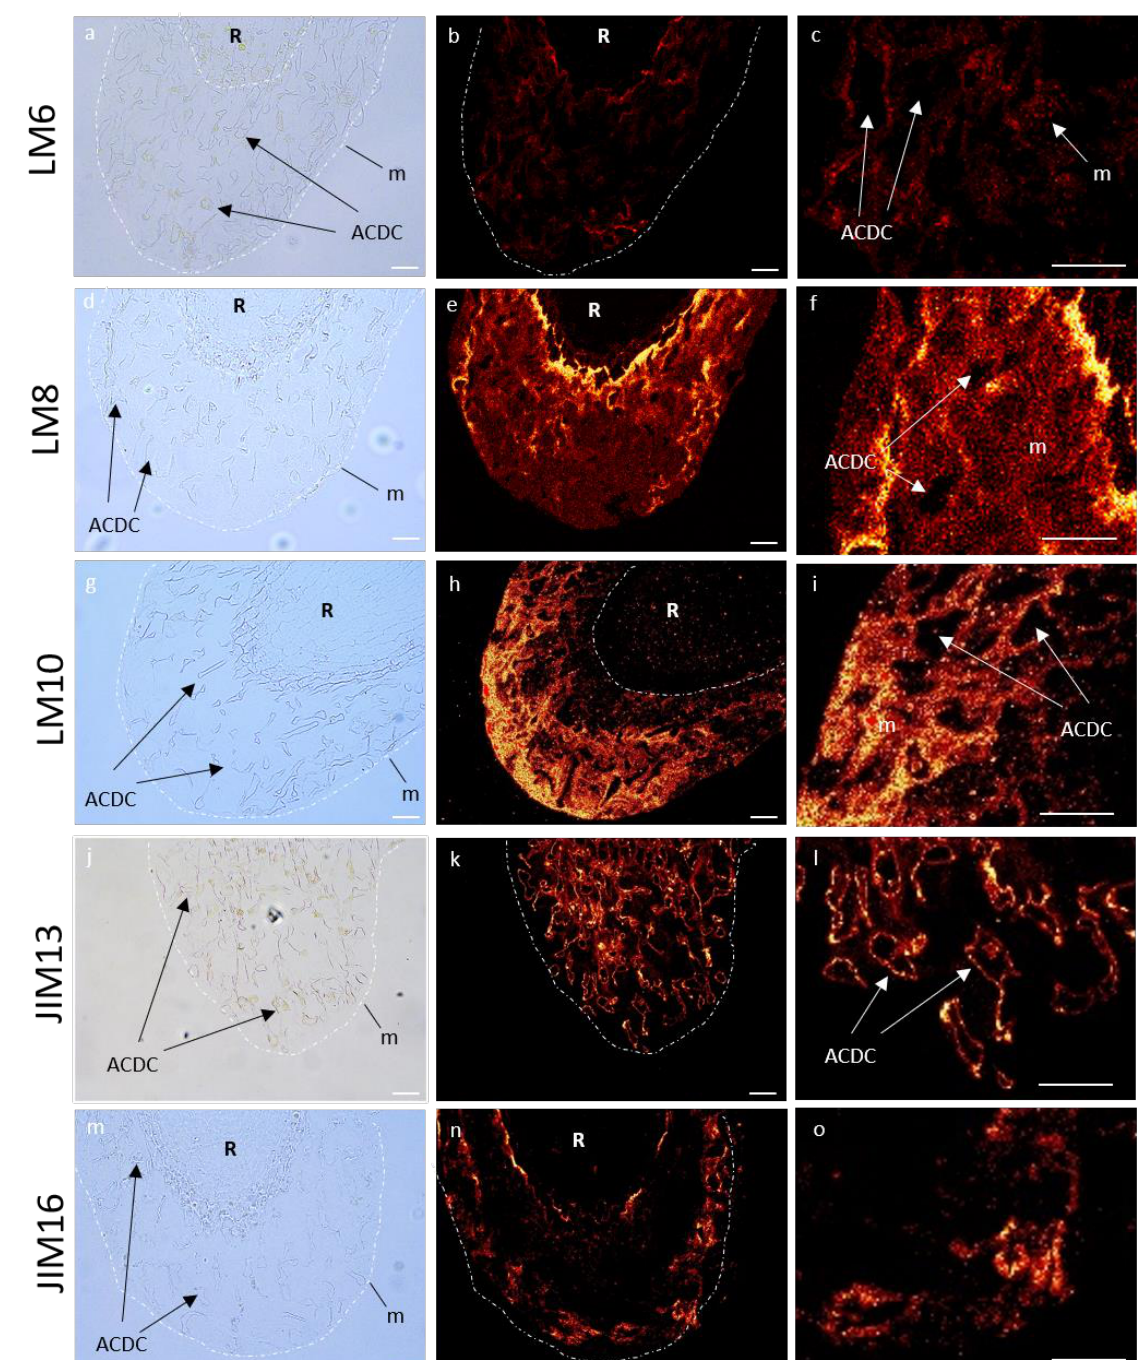
Figure 8. Immunocytochemical characterization of glycopolymers of control P. nigra root extracellular trap. LM6 branched arabinan side chains from rhamnogalacturonan 1 ( a – c ), LM8 xylogalacturonan ( d – f ), LM10 xylan ( g – i ), JIM13 arabinogalactan protein ( j – l ), and JIM16 arabinogalactan protein ( m – o ). Left column: bright field images defining mucilage and AC-DC, central column: corresponding images with fluorescence, right column: zoom of fluorescence images. AC-DC: root associated cap derived cell, m: mucilage, R: root. Bars: 25 µm.